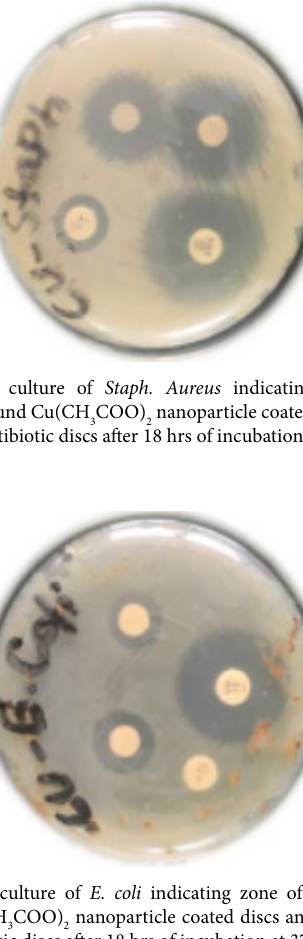
Fig. 8. Lawn culture of E. coli indicating zone of inhibition around Cu(CH 3 COO) 2 nanoparticle coated discs and standard antibiotic discs after 18 hrs of incubation at 37 ° C Fig. 6. Photomicrographs of Digimizer, mean particle size and area along with its intensity and length of nickel oxide nanoparticles at resolution of 15 kv x 60,000